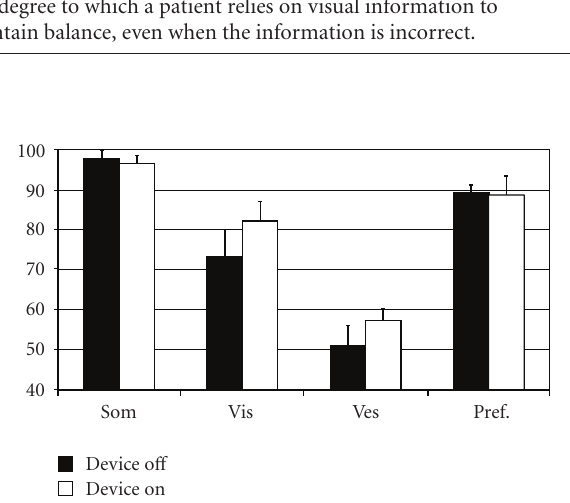
Figure 3: Strategy analysis.